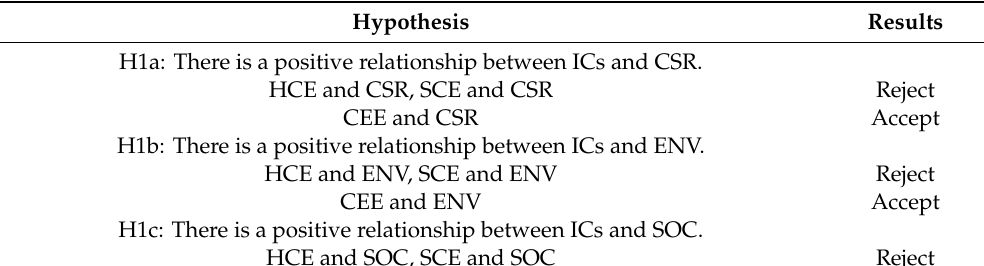
Table 6. Hypotheses